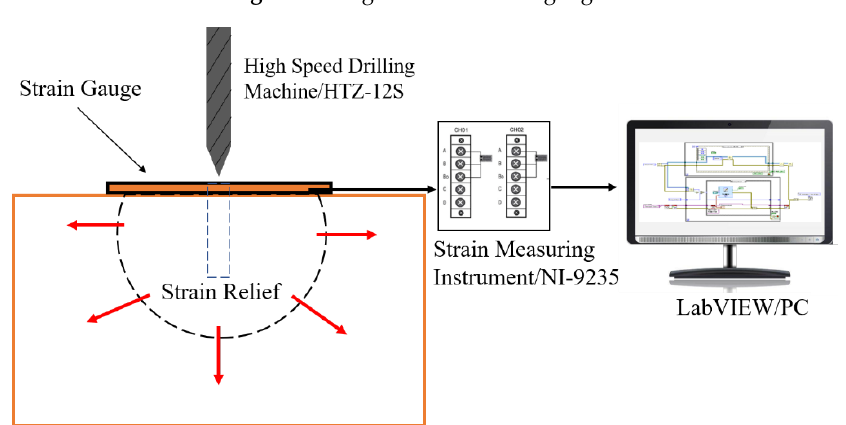
Figure 2. Diagram of the strain gauge.